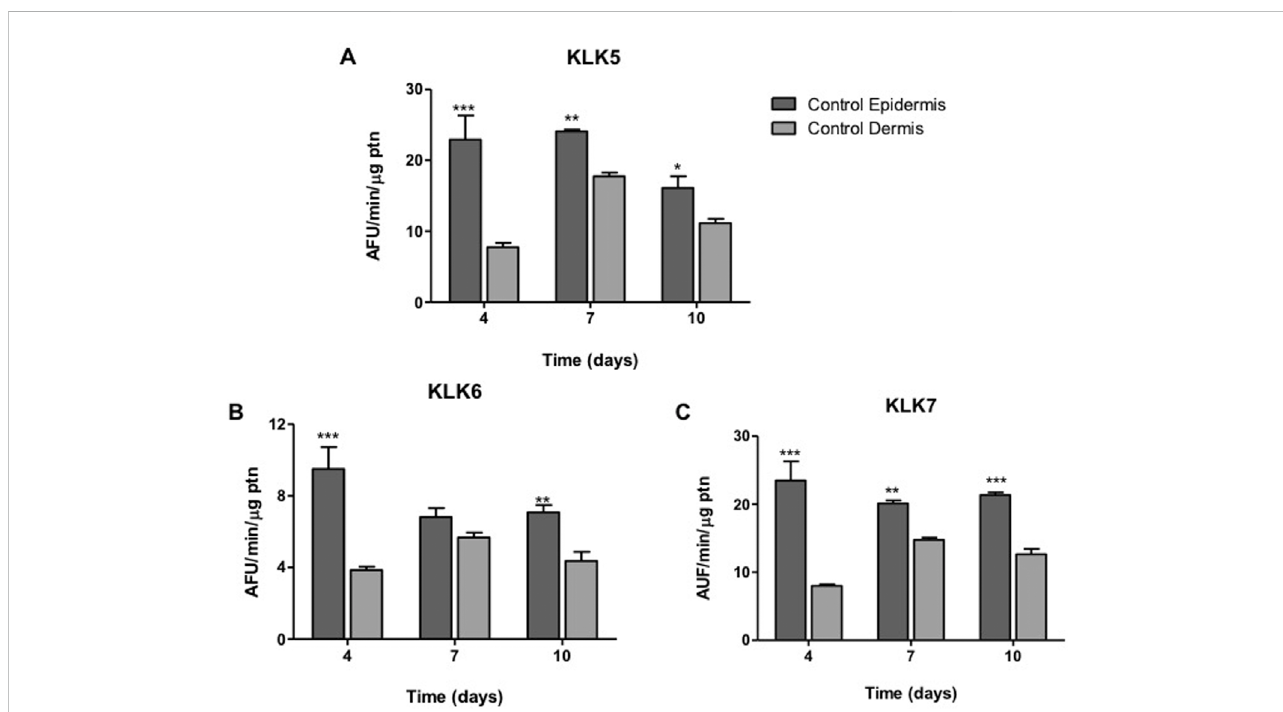
FIGURE 8 KLKactivityindermisandepidermis.Theenzymeactivityof (A) KLK5, (B) KLK6and (C) KLK7wasdetectedonthehydrolysisofFRETsubstratesbyproteins present in the extracts of epidermis (containing basal keratinocytes) and dermis (containing fi broblasts) at different periods (4, 7, 10 days) of ALI. Differences wereanalyzedbyANOVA +Bonferroni post-test. *( p < .05),**( p < .01)or***( p < .001), differentfromdermisinthesamecultivation period.AFU/min/ μ g ptn: arbitrary fl uorescence unit/minute/ μ g of protein in the epidermis or dermis